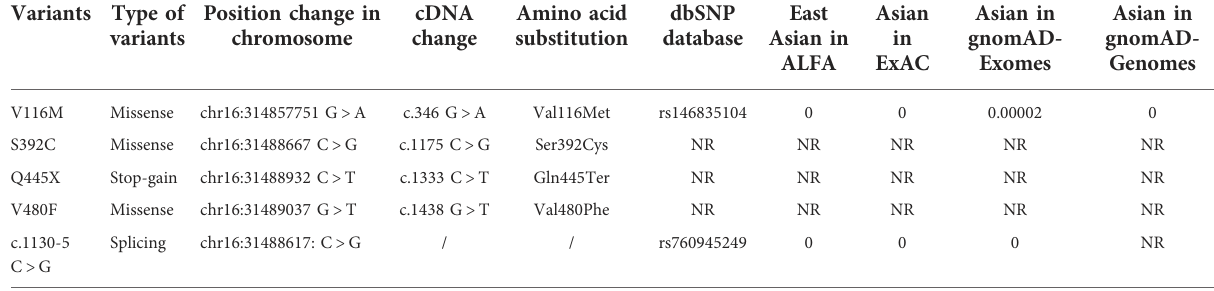
TABLE 2 Allele frequencies for the SGLT2 variants in the Asian population. The version of chromosome database used in this study is GRCh38; the coding sequence positions for the SGLT2 transcript are based on NM_003041; the amino acid positions for the SGLT2 protein are based on